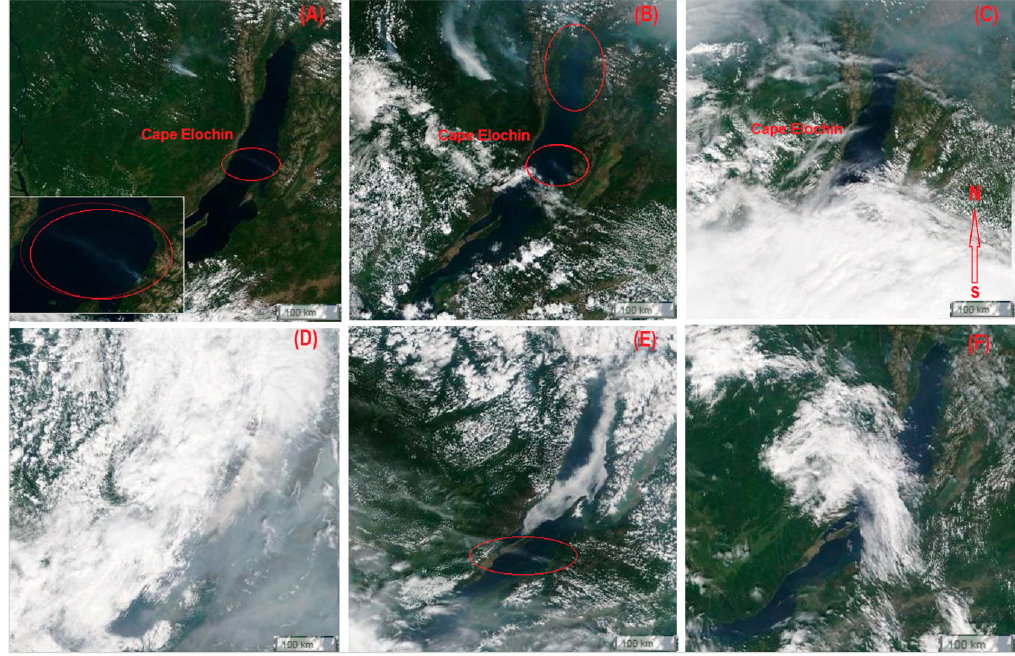
Figure 2. Satellite images of Lake Baikal with smoke plumes from wildfires: ( A )—25 July, ( B )—26 July, ( C )—27 July, ( D )—1 August, ( E ) —2 August, ( F )—3 August [29]. Atmosphere 2020 , 11 , 1230